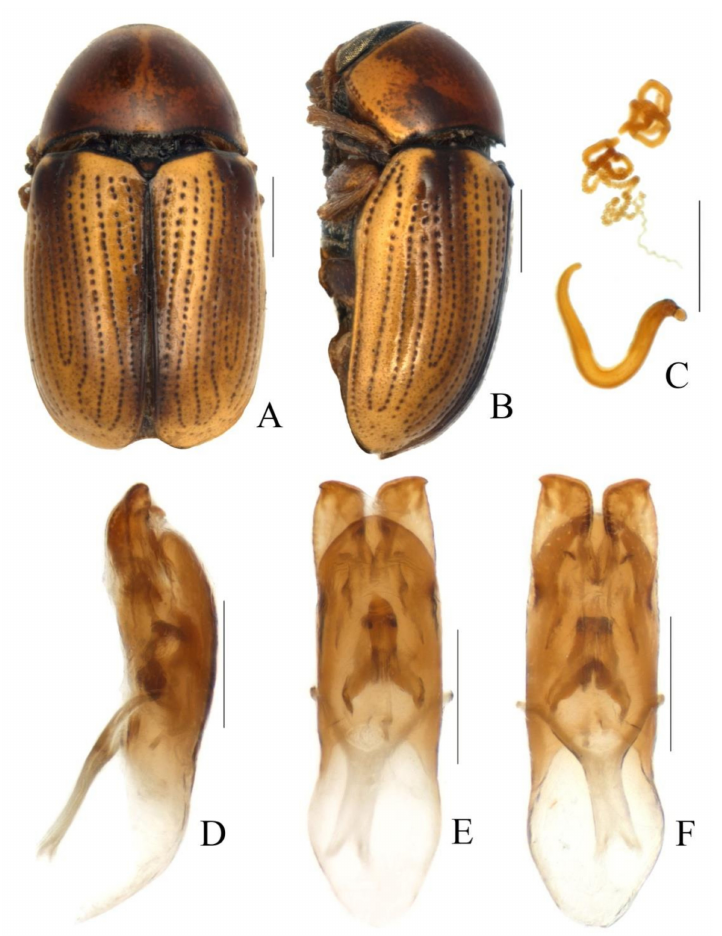
Figures 19 and 20.